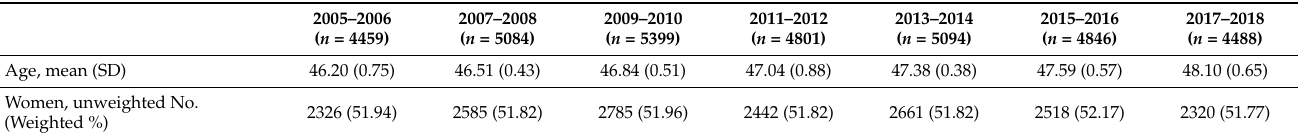
Table 1. Weighted characteristics of participants in seven National Health and Nutrition Examination Surveys from 2005 to 2018.